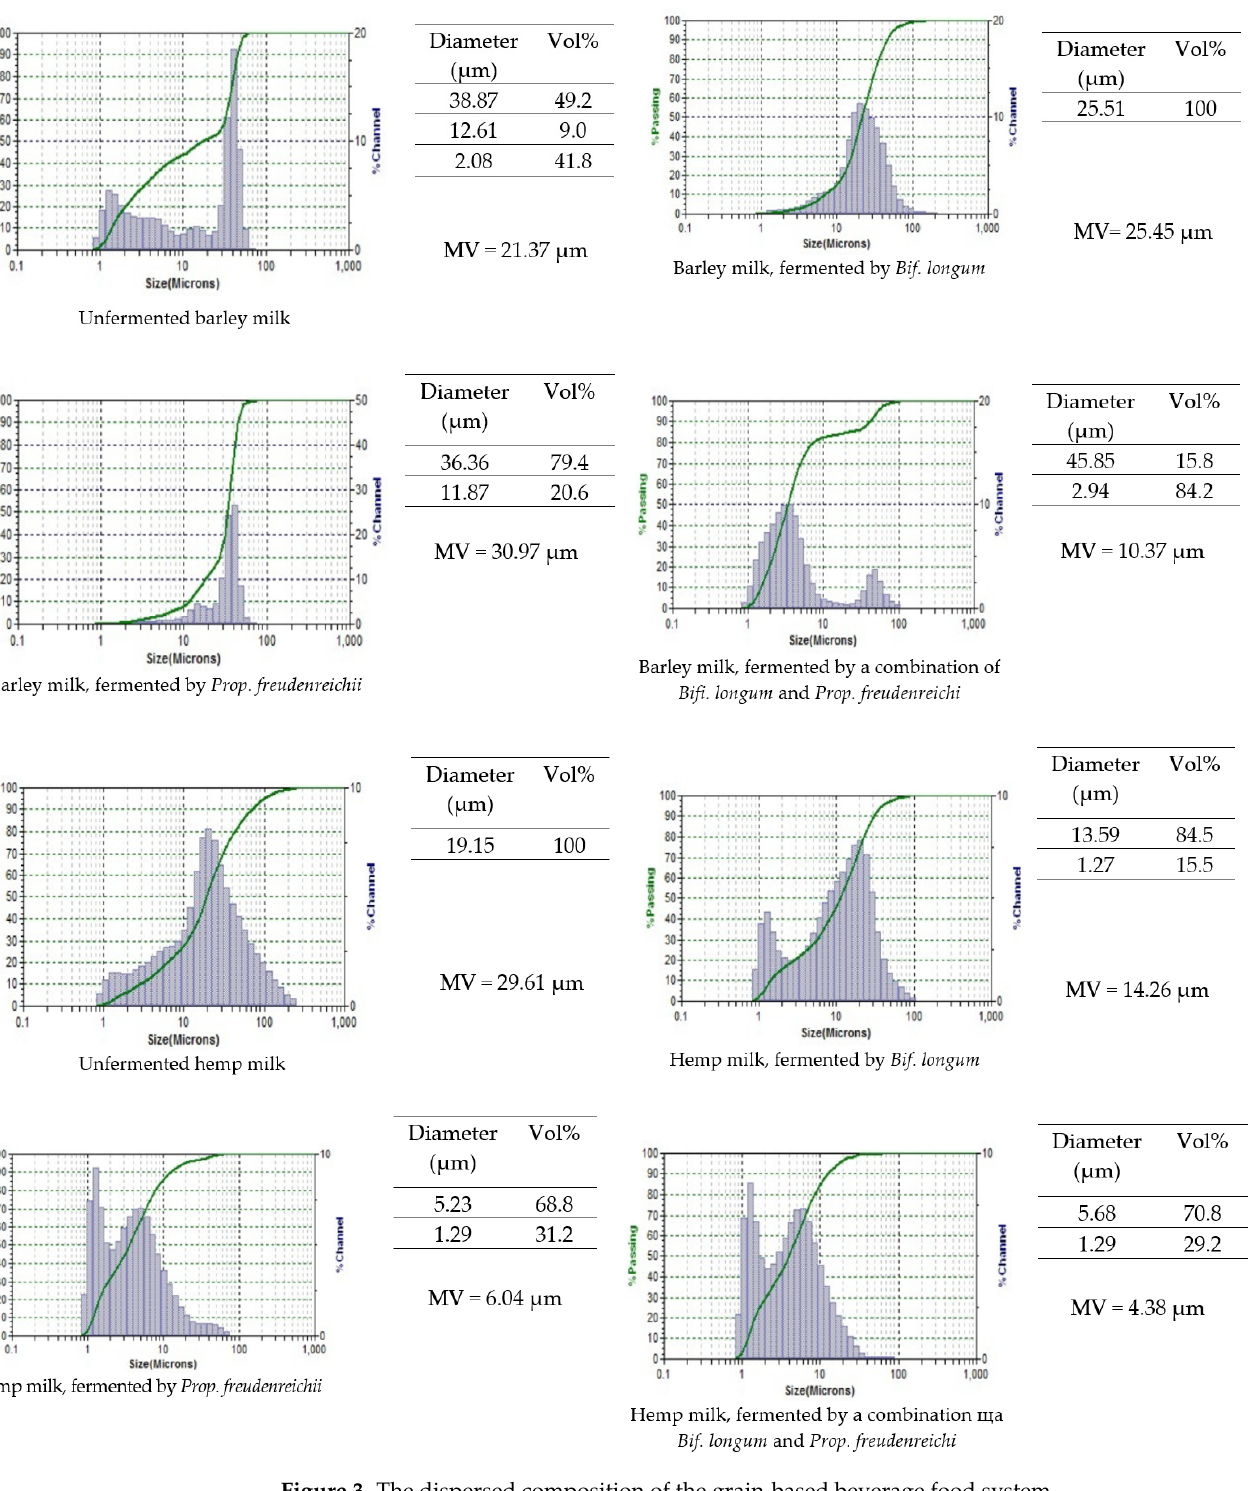
Figure 3. The dispersed composition of the grain-based beverage food system.